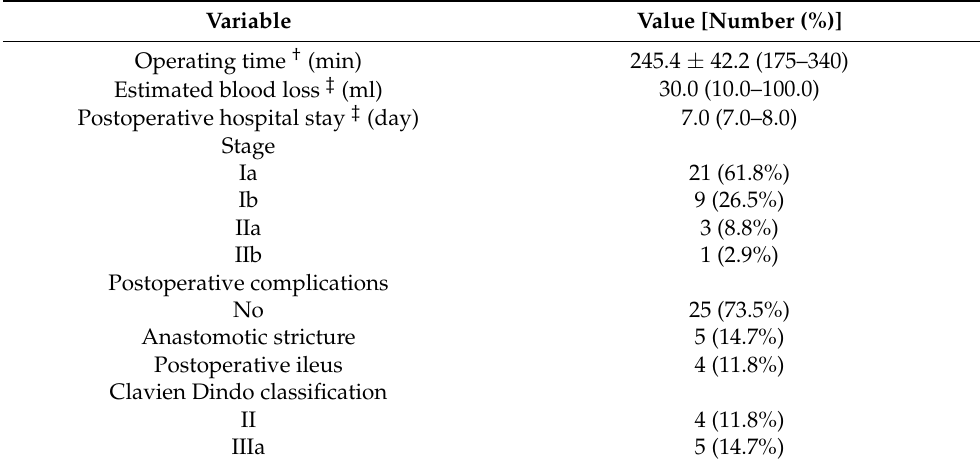
Table 3. Short term outcomes of